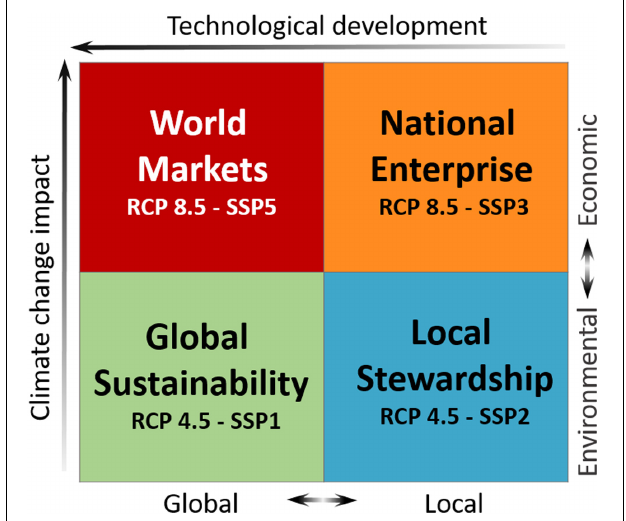
FIGURE 1 | Conceptualization of the four climate change and European aquatic resources (CERES) scenarios in terms of impact and adaptation. Direction of the arrows indicates an increasing development/impact. Double arrows indicate diverging socio-political focus.